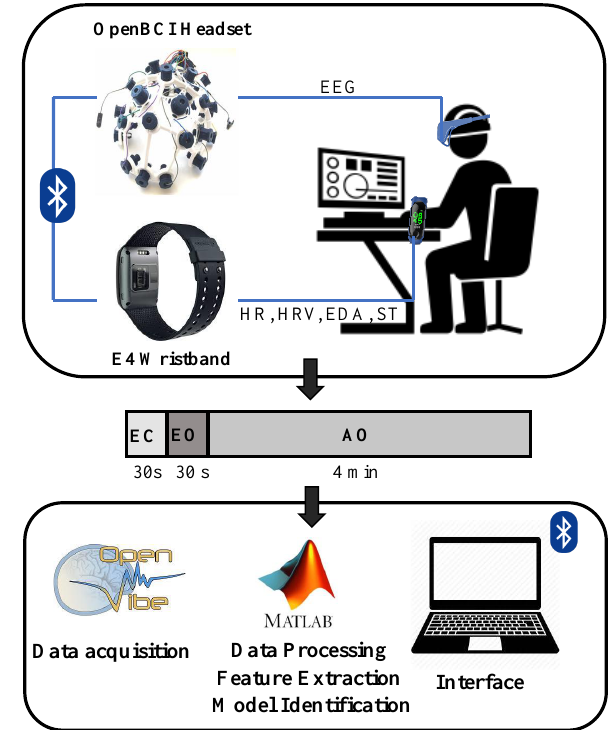
Figure 1. Concept for the experimental design of the fatigue assessment tool. Biometric data are acquired through the OpenBCI and E4 wearables during a relaxed state (EC and EO) and during the AO task. In the AO task, frequent and non-frequent stimuli are presented randomly in a 80:20 proportion. Data are transferred to a PC via Bluetooth, using the OpenVibe software and analyzed offline in Matlab for data processing, feature extraction and model